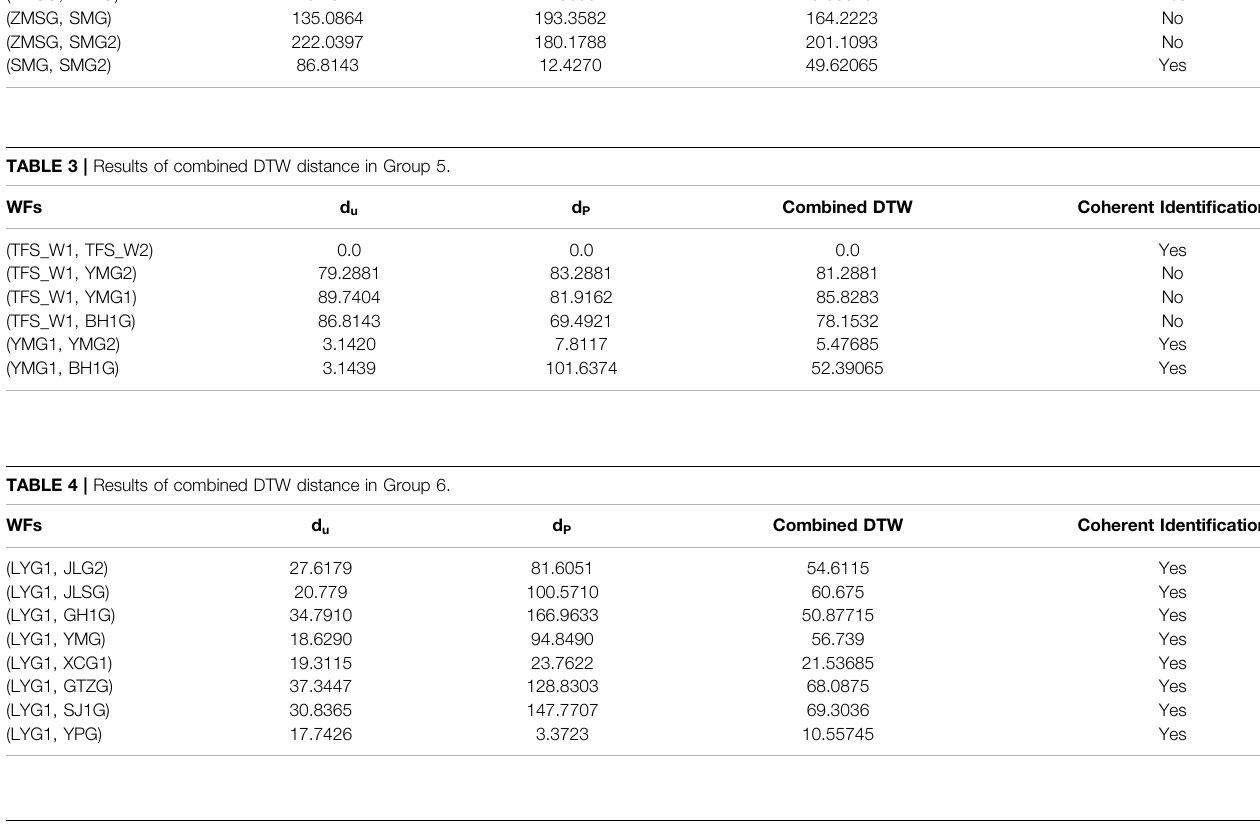
TABLE 5 | Results of combined DTW distance in Group